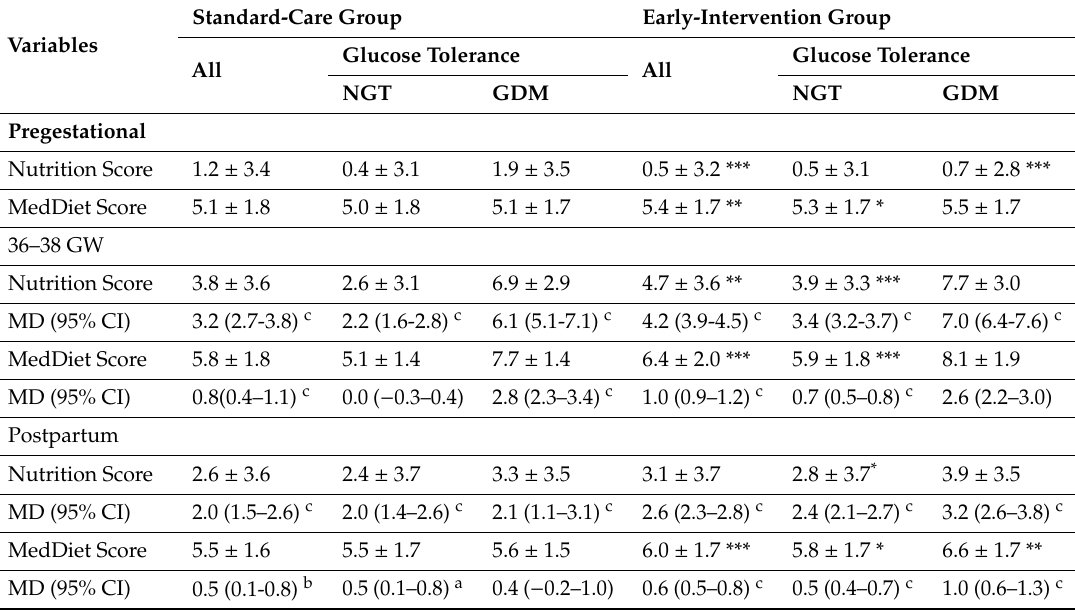
Table 2. Nutrition and MedDiet scores before, during gestation, and at 12–14 weeks postpartum by groups of intervention and subdivided by glucose tolerance.